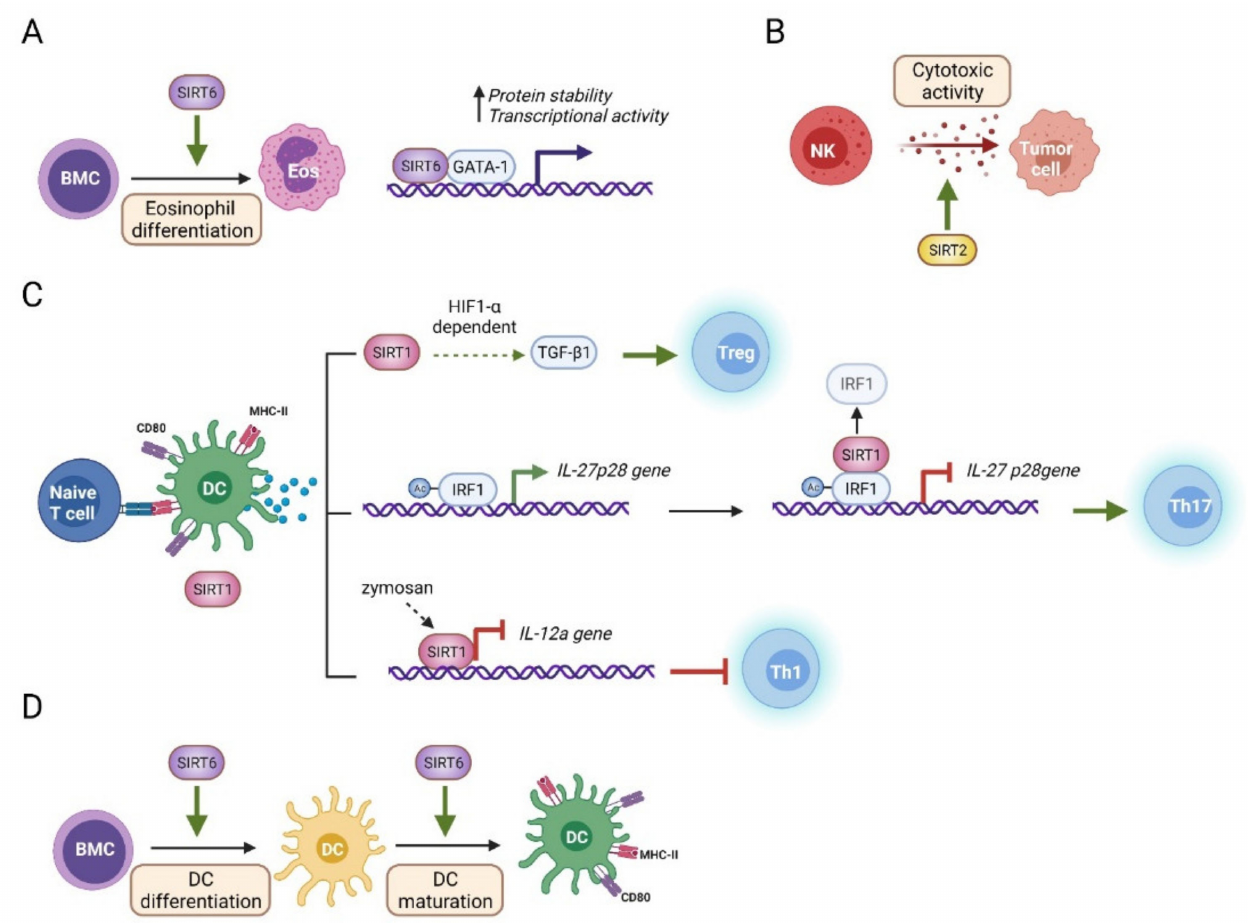
Figure 5. Molecular pathways related to nuclear sirtuin activity in innate immune cells. ( A ) SIRT6 promotes